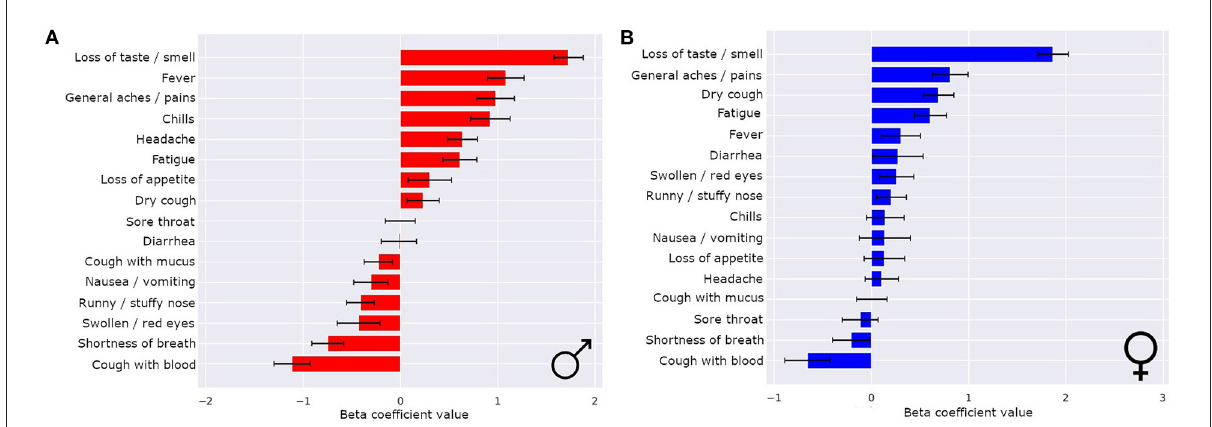
FIGURE4 Sex differences in COVID-19 classifiers enables improved performance and symptom importance in both sexes. The means ± 1 std dev for the beta coefficients from logistic regression bootstrapping for males (A) and females (B)